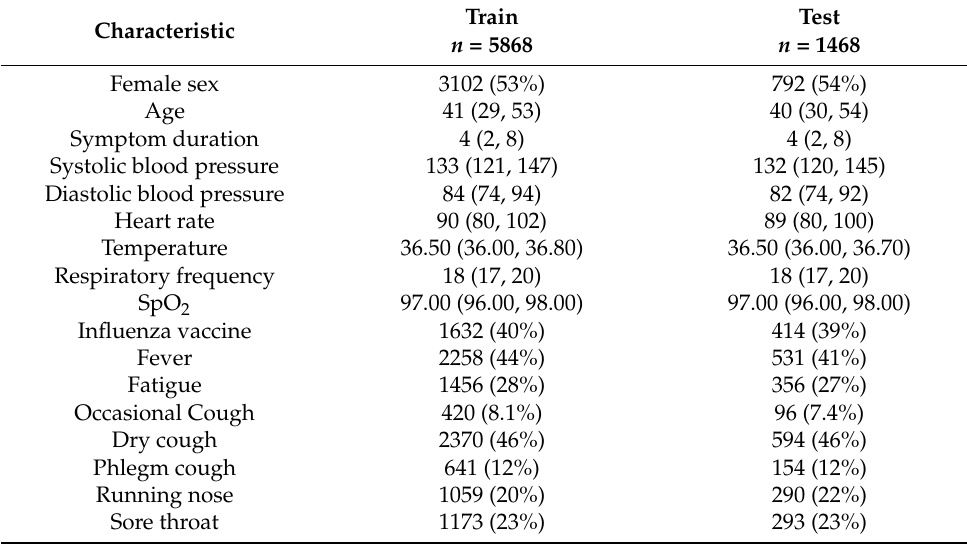
Table 3. Datasets (train and test sets) used in predicting hospitalization in patients with respiratory symptoms during the COVID-19